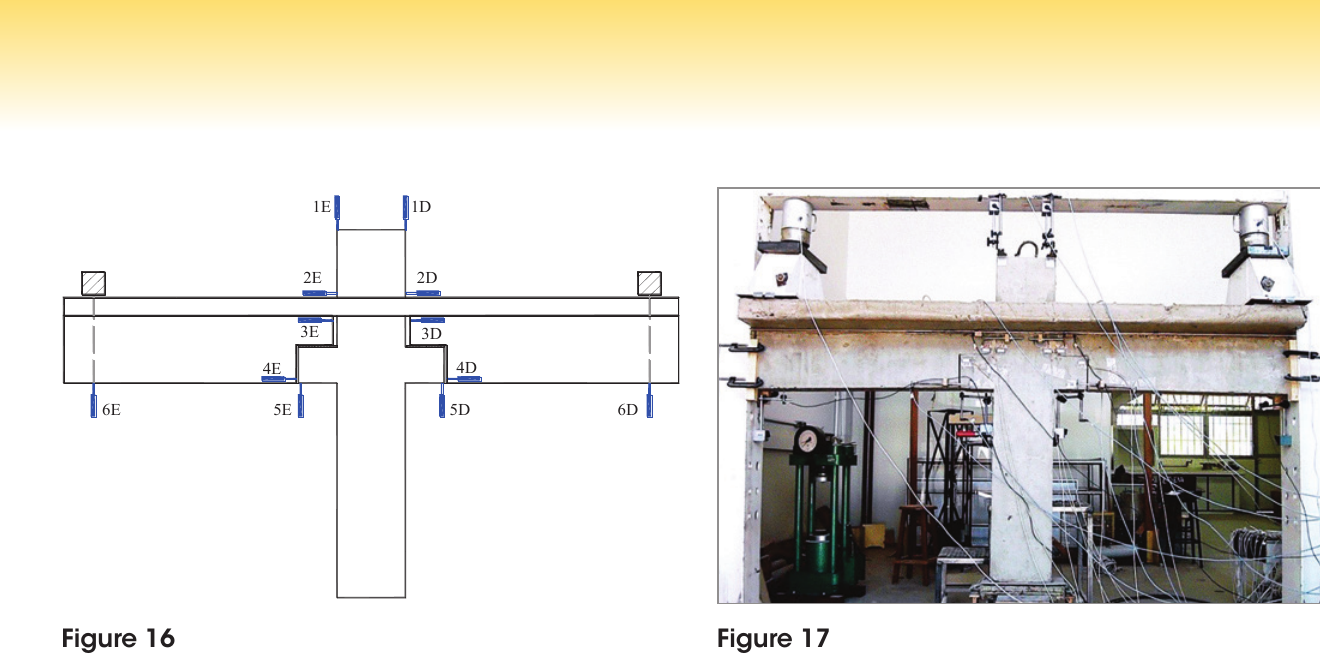
Figure 16 – Position of the displacement transducers for all